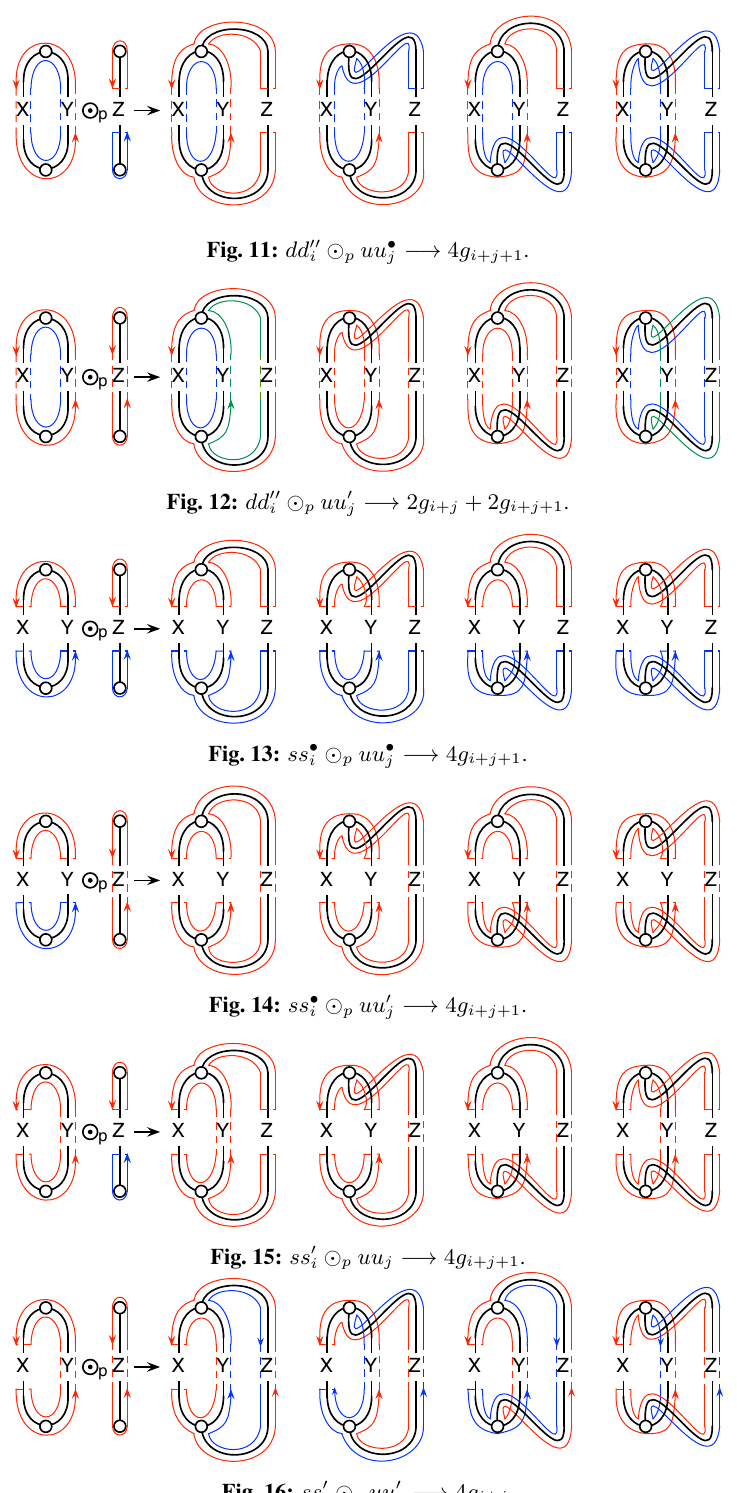
Fig. 16: ss (cid:48) i (cid:12) p uu (cid:48) j −→ 4 g i + j